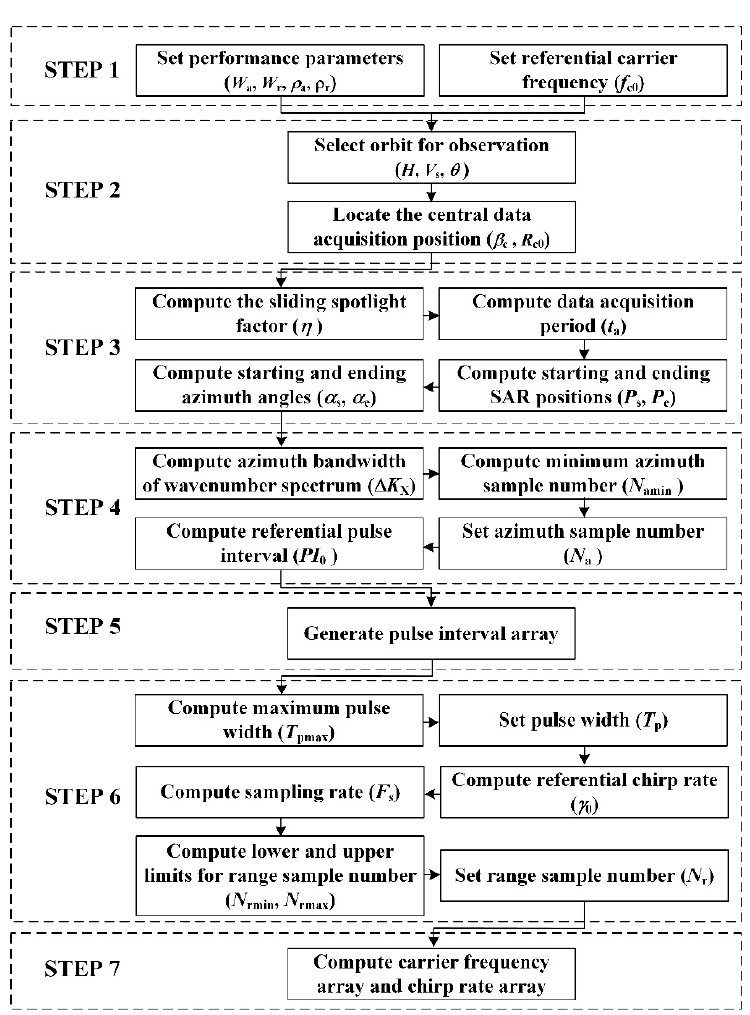
Figure 7. Integrate system parameter design flowchart for the SSS-RSSAR.